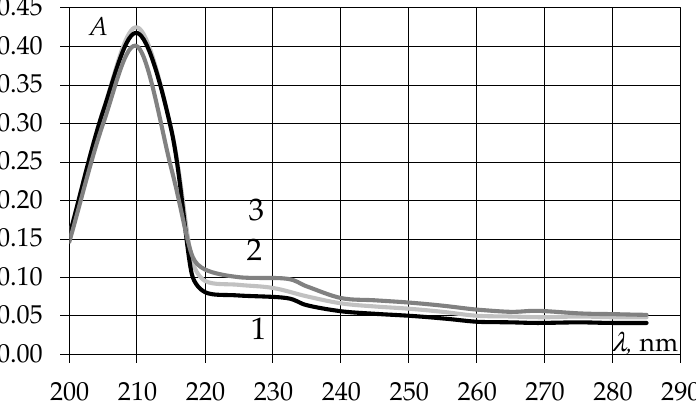
Figure 1. UV spectra of 0.02% isooctane solutions of EAHP samples, which were stored at a temper- ature of 20 ± 1 °C for: 1—0 days; 2—60 days and 3—100 days.